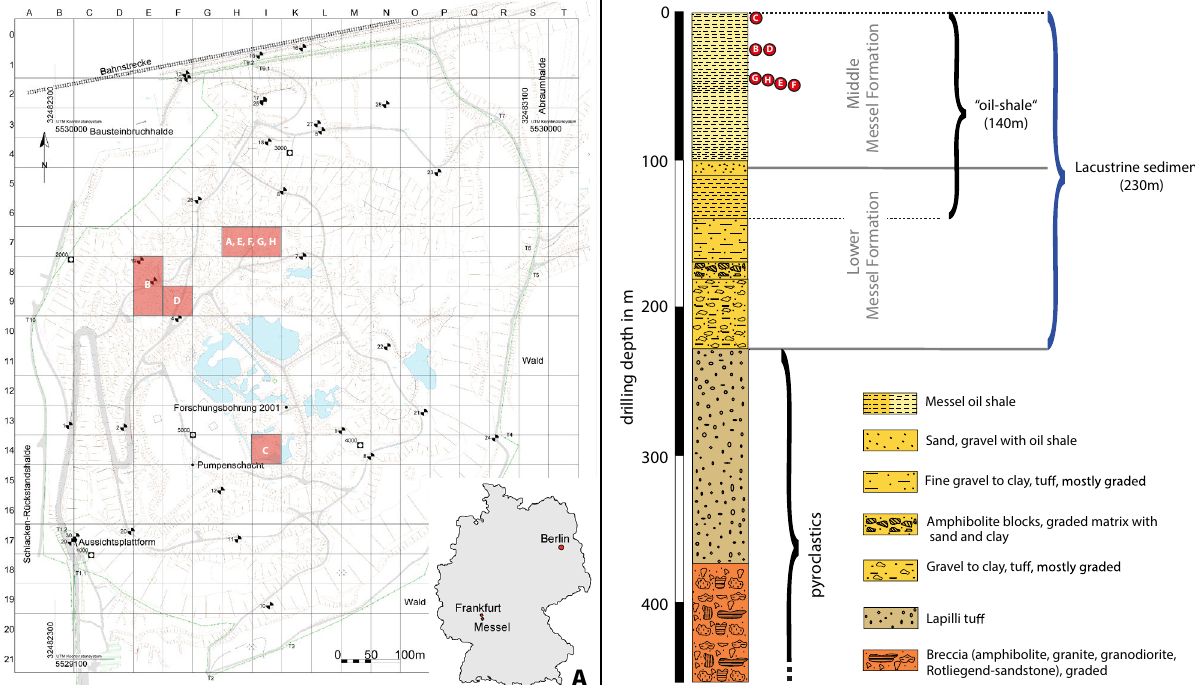
Figure 1. ( A ) Map of the Grube Messel site (from 12 ) with the location of each shrimp fossil ( A – H ) indicated. ( A ) SF-MeI 5933 (holotype); ( B ) SF-MeI 13611; ( C ) SF-MeI 14640; ( D ) SF-MeI 16018; ( E ) HLMD-Me-10684; ( F ) HLMD-Me-10646; ( G ) HLMD-Me-13919 and ( H ) HLMD-Me-13920. ( B ) Section of the Grube Messel core (modified from 13 ). Red circles indicate the corresponding layers where the fossil shrimps were found. Depth: for ( C ) ca. 2.96m to 2.16m; for ( B ) and ( D ): ca. 24.86m to 23.86m; for ( A ): ca. 27.46m to 27.06m; for ( G ): ca. 46.49m to 45.97m; for ( H ): ca. 46.03m; for ( E ): ca. 46.26m; for ( F ): ca.